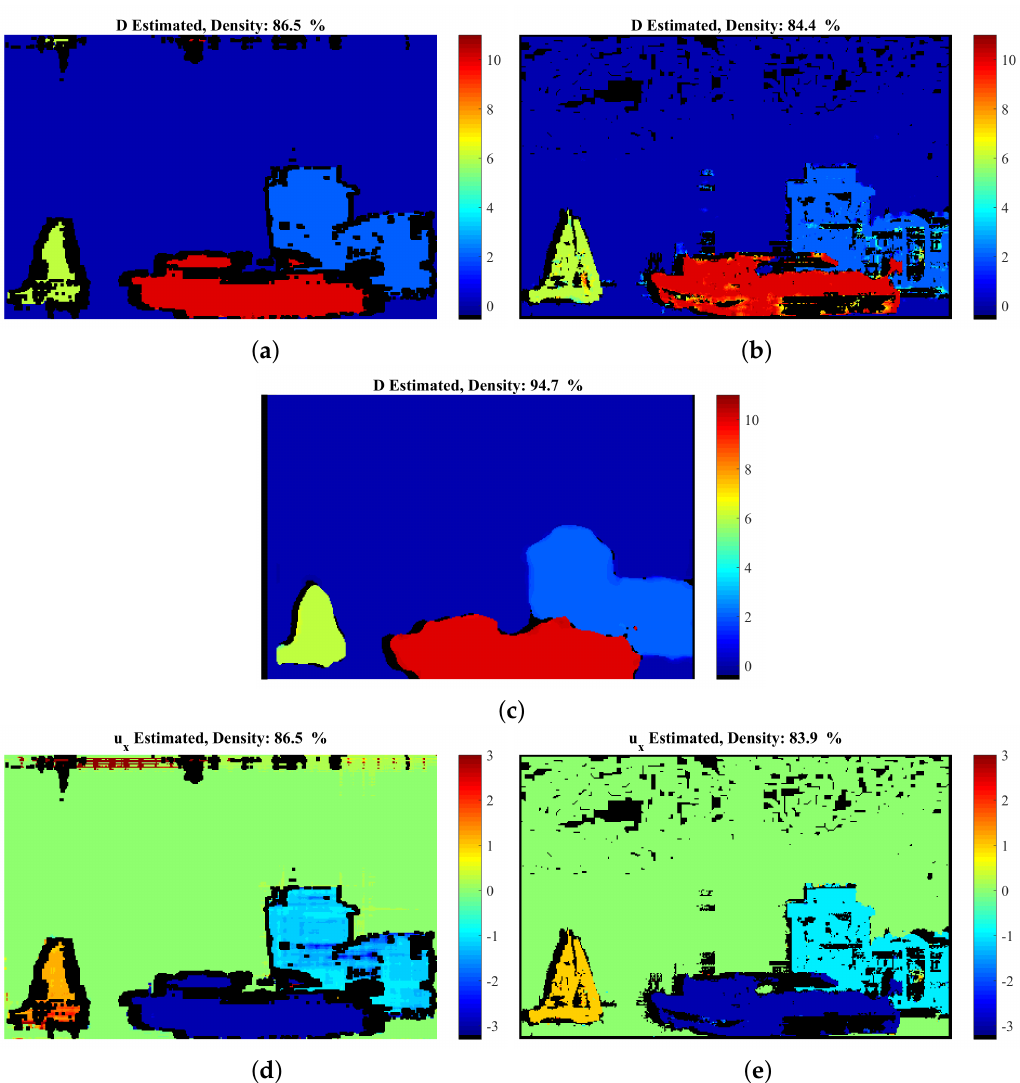
Figure 7. Artificial “Futuristic White-Tower” sequence: comparative results: estimated disparity map of ( a ) the proposed method at density 86.5%, ( b ) GCSF [26] with density 84.4% and ( c ) MatCVTlbx-SemiG [26] with density 94.7%; estimated flow-field of ( d ) the proposed method and ( e ) GCSF [26]. For the corresponding estimation error, please refer to Table 2 and the diagrams of Figure 8.